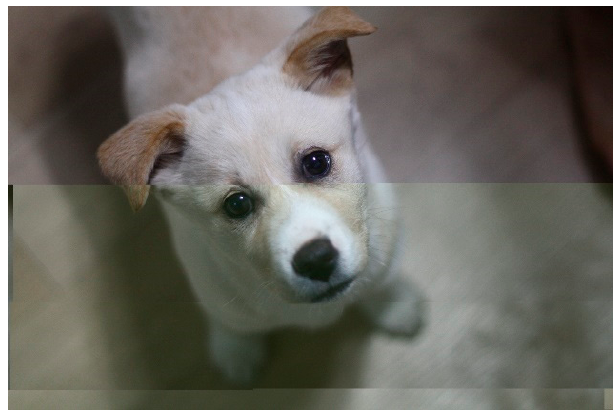
Figure 14. Video frame obtained by client following packet loss.